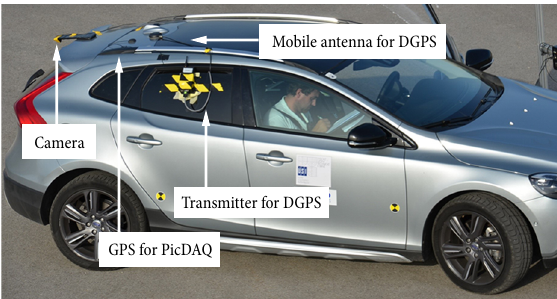
Fig. 1. External measurement equipment installation on the tested vehicle – Volvo V40 T5 AWD Cross Country